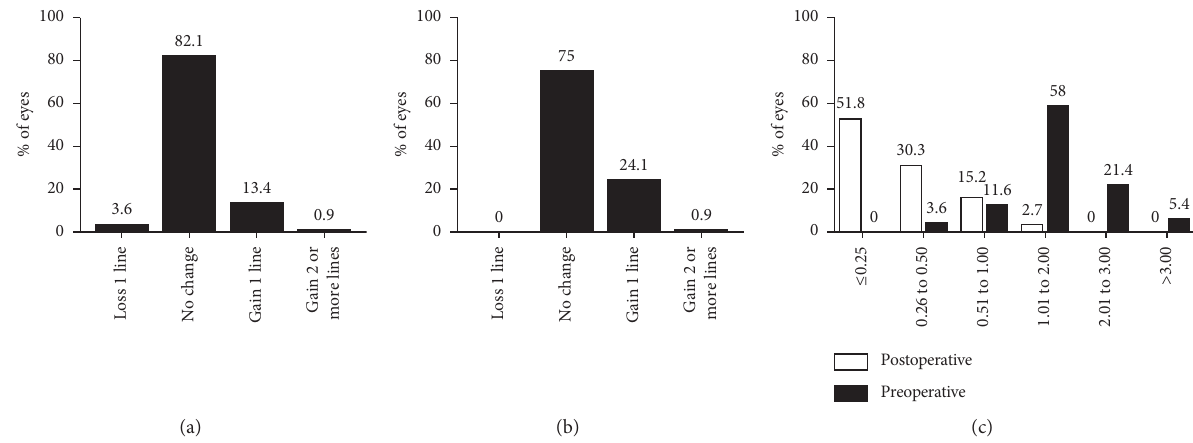
Figure 2: Visual acuity and refractive outcomes at 12 months after surgery. (a) Preoperative BCVA vs postoperative UCVA. (b) Pre- Table 2: Postoperative characteristics of patients after TICL implantation. Characteristic